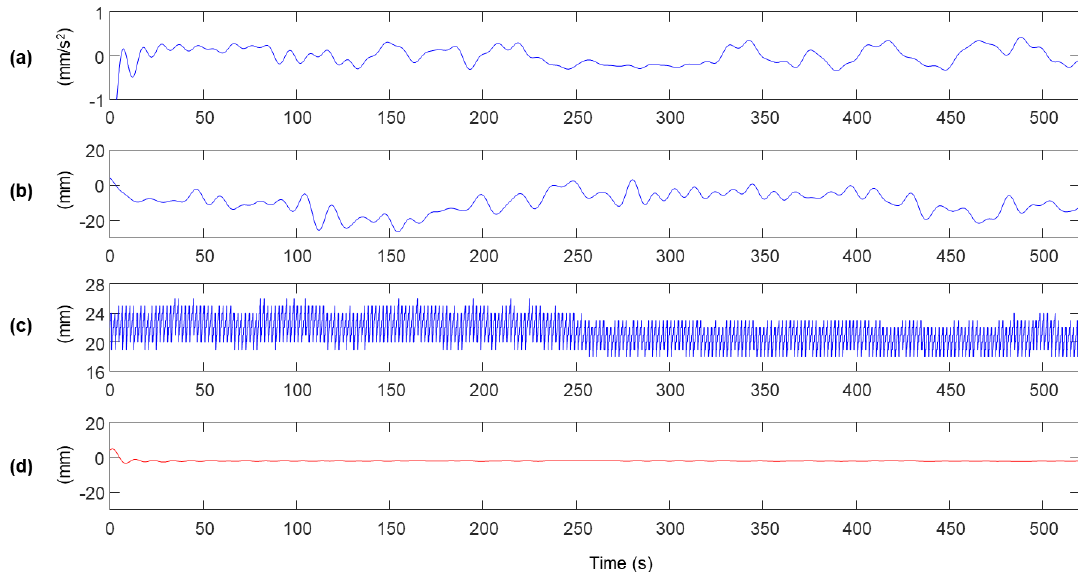
Figure 5. Measurements obtained from the lab-scale experiment: ( a ) acceleration from the accelerometer ( 𝑥̈ 𝑚𝑎 (𝑘) ), ( b ) displacement from RTK-GNSS ( 𝑥 𝑚𝑟 (𝑘) ), ( c ) error standard deviation from RTK-GNSS ( 𝜎 𝑚𝑟 (𝑘) ), and ( d ) reference displacement from a laser displacement sensor ( 𝑥(𝑘) ).